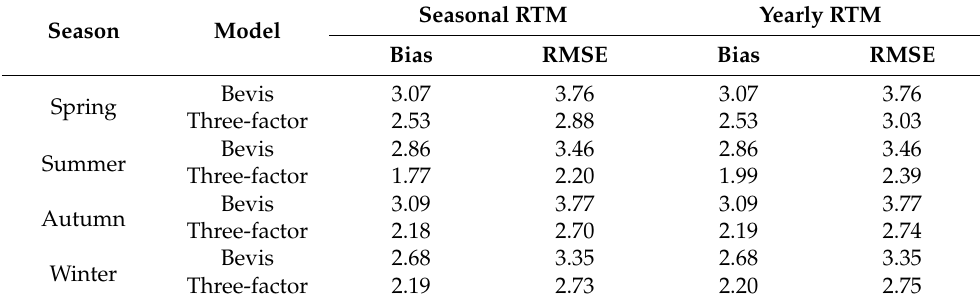
Table 9. The biases and RMSE of the Bevis model, seasonal and yearly three-factor RTM-derived T m in the Yangtze River Delta region during 2016–2017 (K).